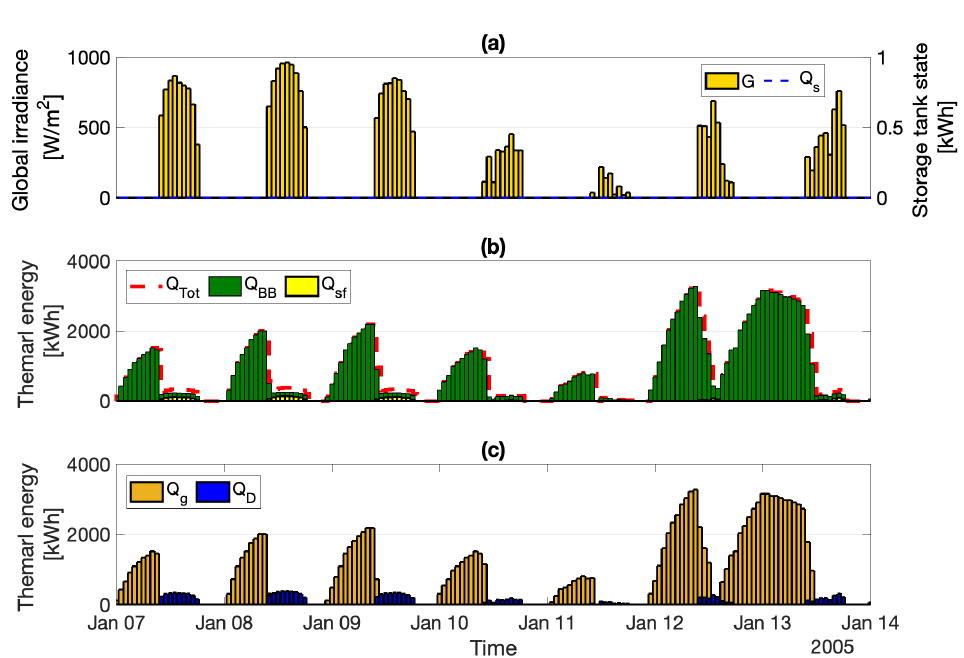
Figure 7. Simulation results during the week of 7 to 14 January. ( a ) Global irradiance ( G ) and storage tank state ( Q s ), ( b ) the total thermal energy demand of the system ( Q Tot ), contribution of the biomass boiler ( Q BB ) and contribution of the solar field ( Q sf ), and ( c ) the greenhouse thermal energy demand ( Q g ) and thermal desalination facility demand ( Q D